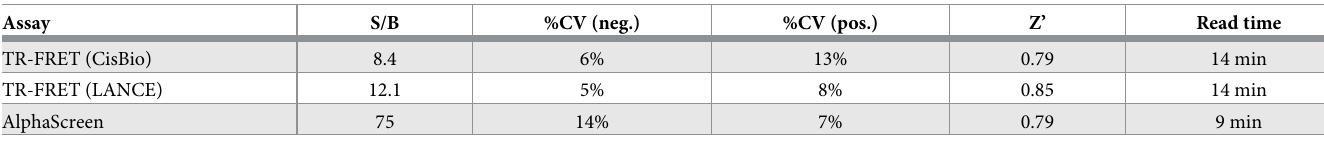
Table 4. Optimized assay performance in 1536 well plate